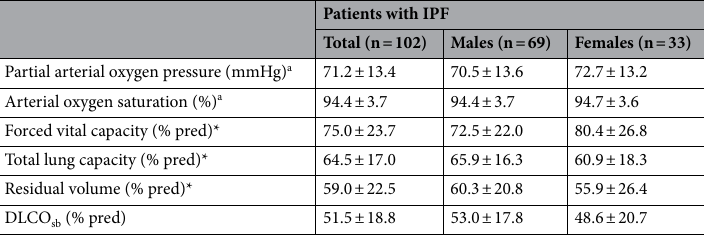
Table 2. Lung function in the 102 patients with idiopathic pulmonary fibrosis (IPF) participating in the study. Data are expressed as mean ± SD. DLCO sb single breath diffusion lung capacity for carbon monoxide. * p < 0.05 between genders. a Measured at rest while patients were breathing in ambient air.